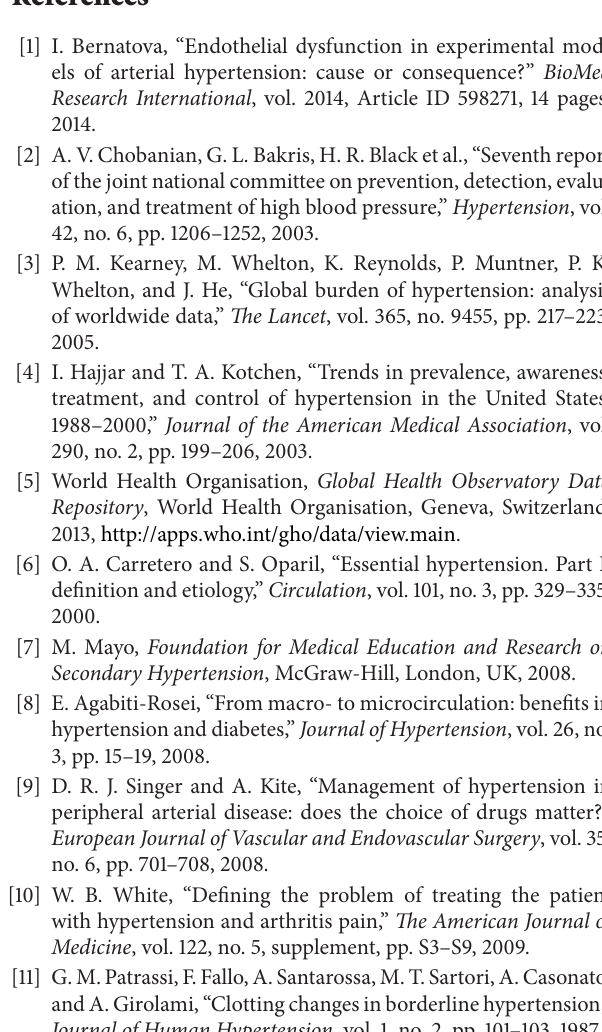
Figure 8: Correlation of systolic and diastolic blood pressure of normotensive subjects across gender distribution. Purple lines and points: females. Blue line and points: females. Green line and points: males. Red line and points: males. Number of male normotensive subjects ( 𝑛 ) = 15. Number of female normotensive subjects ( 𝑛 ) = 15.